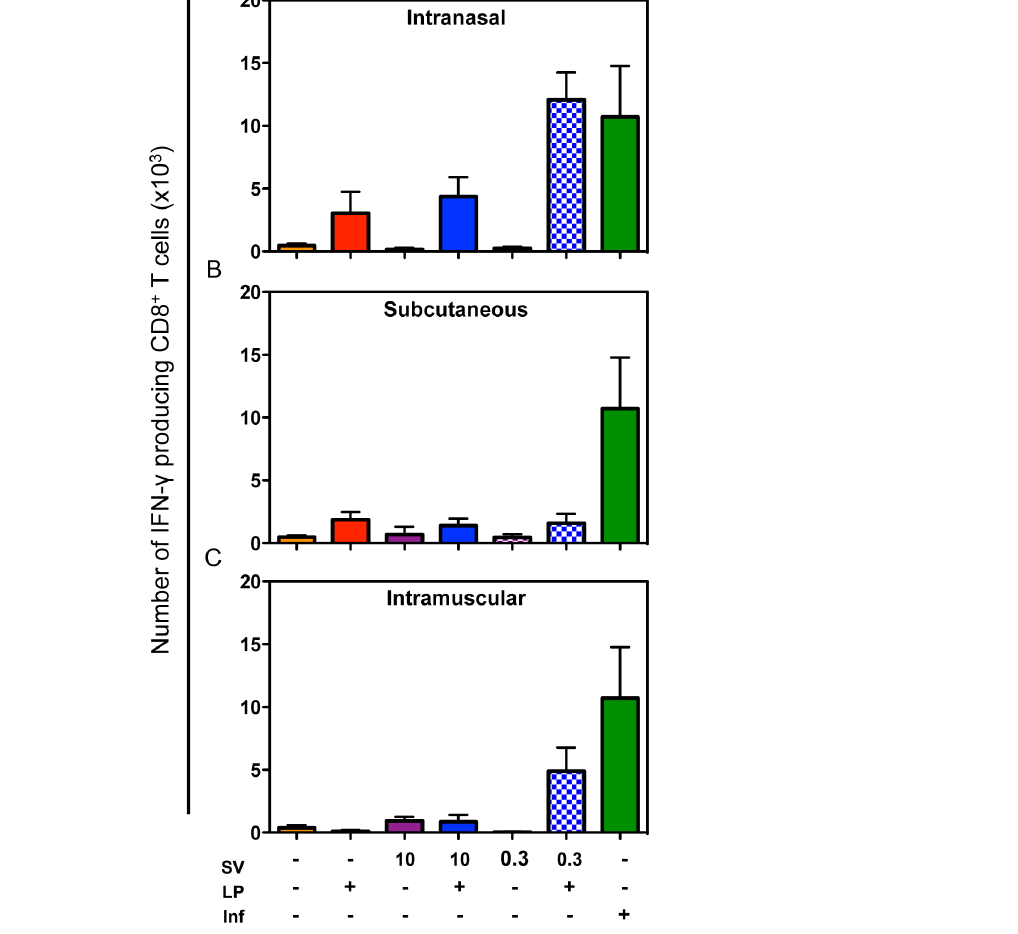
Fig. 5. Influenza epitope-specific CD8 + T cells in the lungs of vaccinated mice after recall by viral challenge. Mice were immunised once by the i.n. (A), s.c. (B) or i.m. (C) routes with 10 nmol lipopeptide (LP), 10 or 0.3 m g of HA as split virus (SV) or combinations of these as indicated ( + ). Controls were infected with 10 4.5 pfu of virus (Inf) or PBS. One month post immunisation, mice were challenged by the i.n. route with 10 4.5 pfu of virus. The IFN- c secreting CD8 + T cells in the lungs 5 days later that were specific for the TYQRTRALV epitope were enumerated by ICS. Data are presented as the total CD8 + Tcells producing IFN- c in response to peptide stimulation minus the number detected in the absence of stimulation. Bars represent the geometric mean for the group (n 5 5) and error bars indicate the standard error.